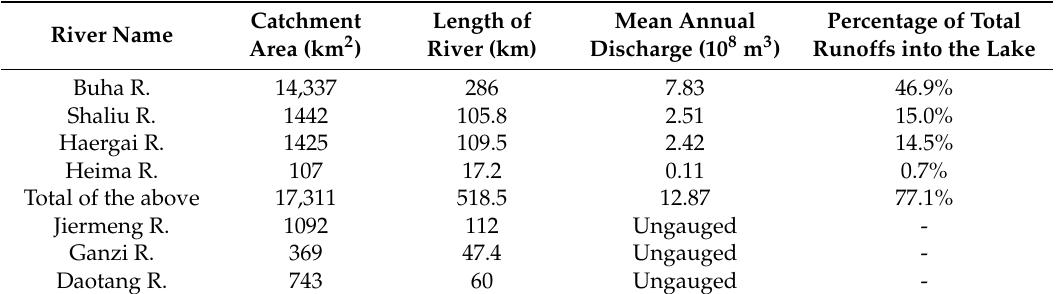
Table 1. Characteristics of flow into Qinghai Lake from its main rivers.